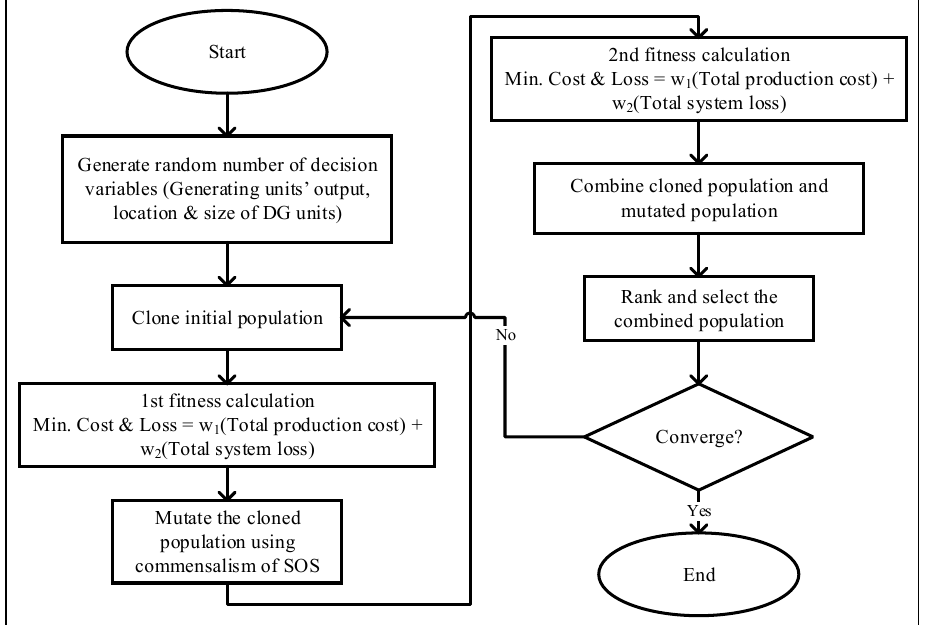
Figure 1. Overall MOICEP processes for the total production costs and total system loss minimiza-